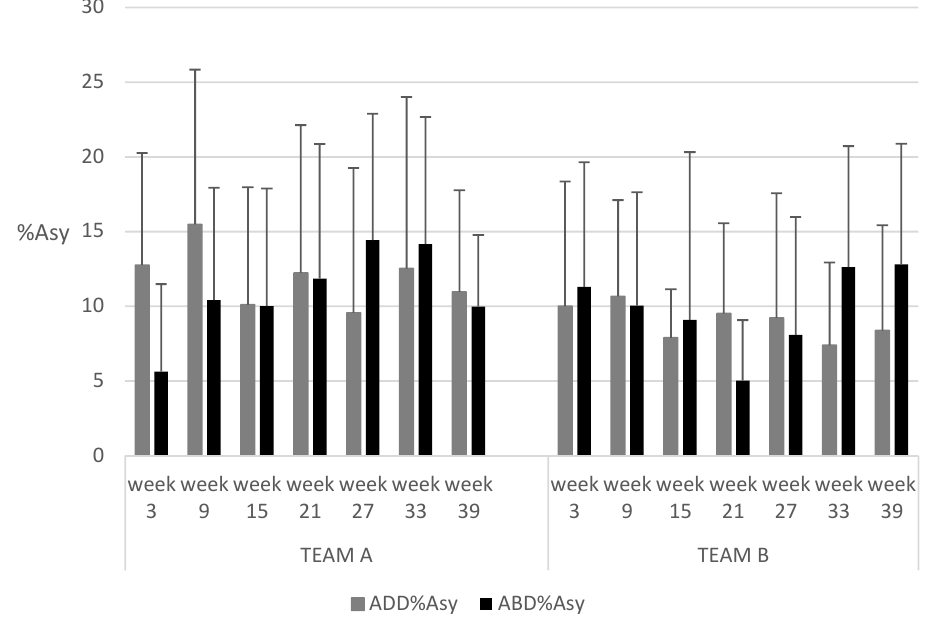
Figure 4. Evolution of ADD and ABD percentage of asymmetries between dominant and non-dominant legs (%Asy) during the season. ADD%Asy: ADD percentage of asymmetries between dominat and non-dominant legs; ABD%Asy: ABD percentage of asymmetries between dominant and non-dominant legs.